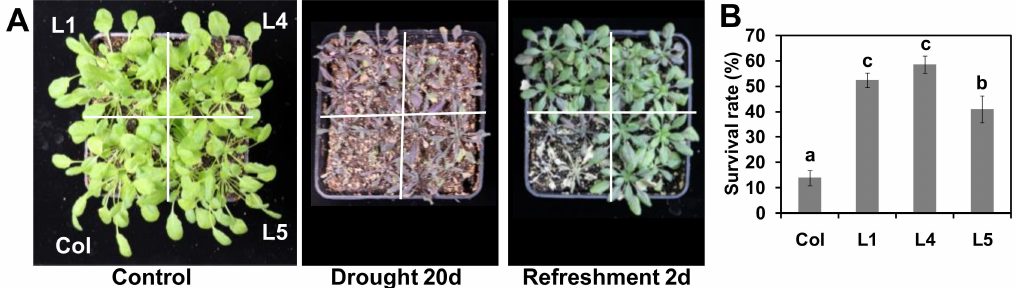
Figure 8. Assessment of drought tolerance in “Col” and transgenic Arabidopsis plants. ( A ) Representative images of four-week-old plants; ( B ) Survival rates of WT and transgenic lines 2 days after rehydration began. Error bars represent SD based on three independent replicates. For ( B ), bars not labeled with same letters in each panel indicate values are significantly different at p < 0.05, based on one-way ANOVA and Duncan’s